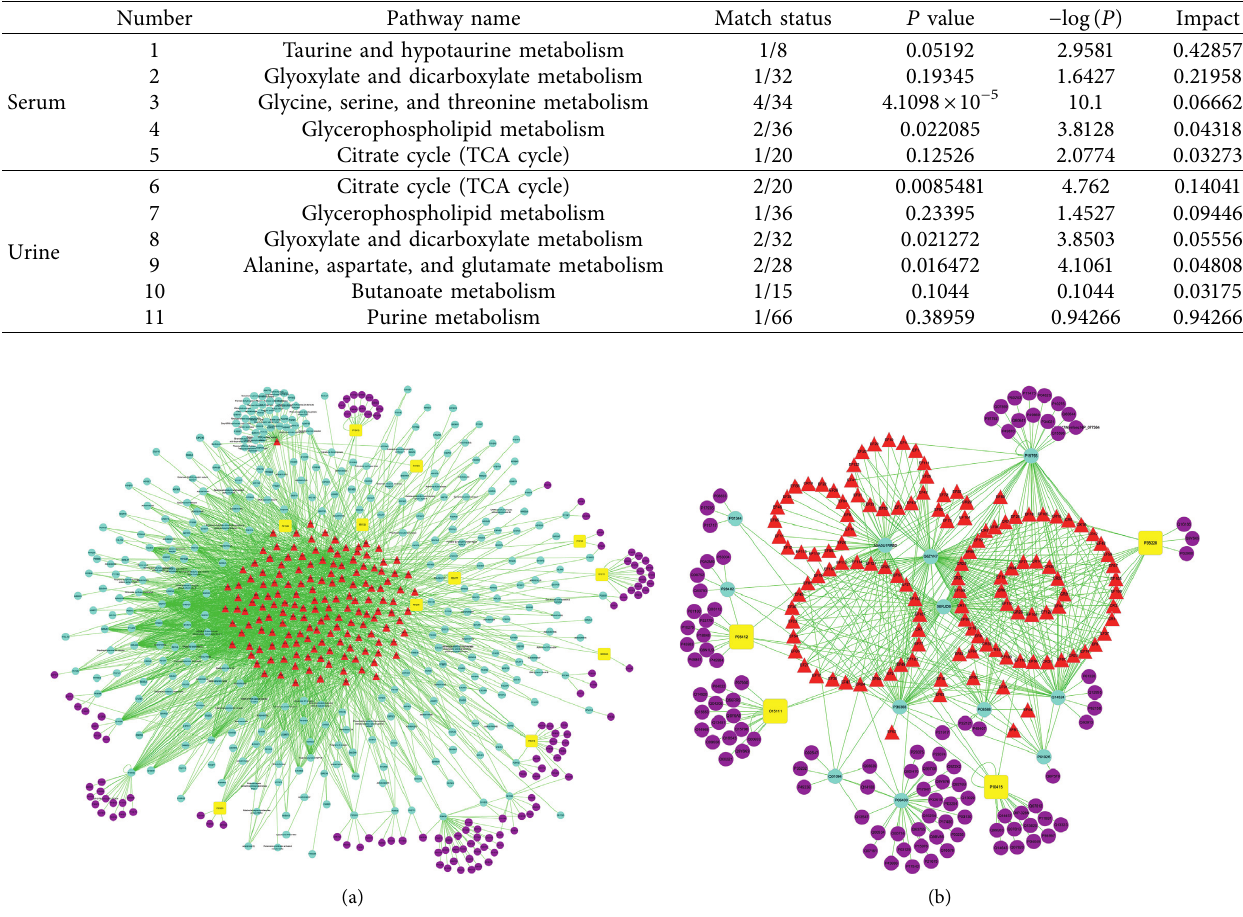
Figure 8: The crucial compound-CAG target-metabolite network. (a) All target information participating in the treatment of CAG by ZJP. (b) Key target information participating in the treatment of CAG by ZJP. The red triangle represents the active chemical composition of ZJP; the blue dots represent the protein targets of ZJP; the yellow square represents the common target for ZJP and disease; and the purple dots represent targets associated with potential